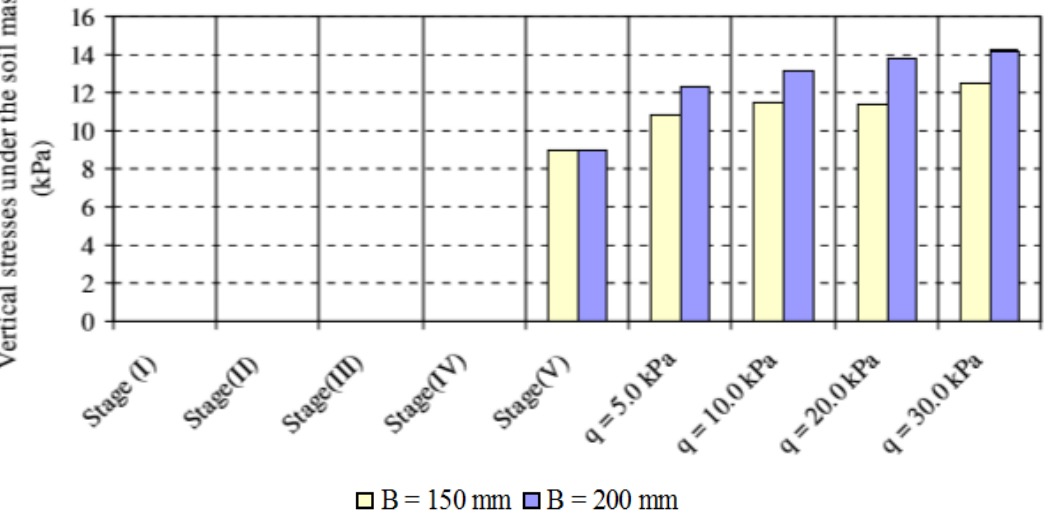
Figure 23. Influence of footing width on the slope face vertical stresses under the nails at mid-height of slope.